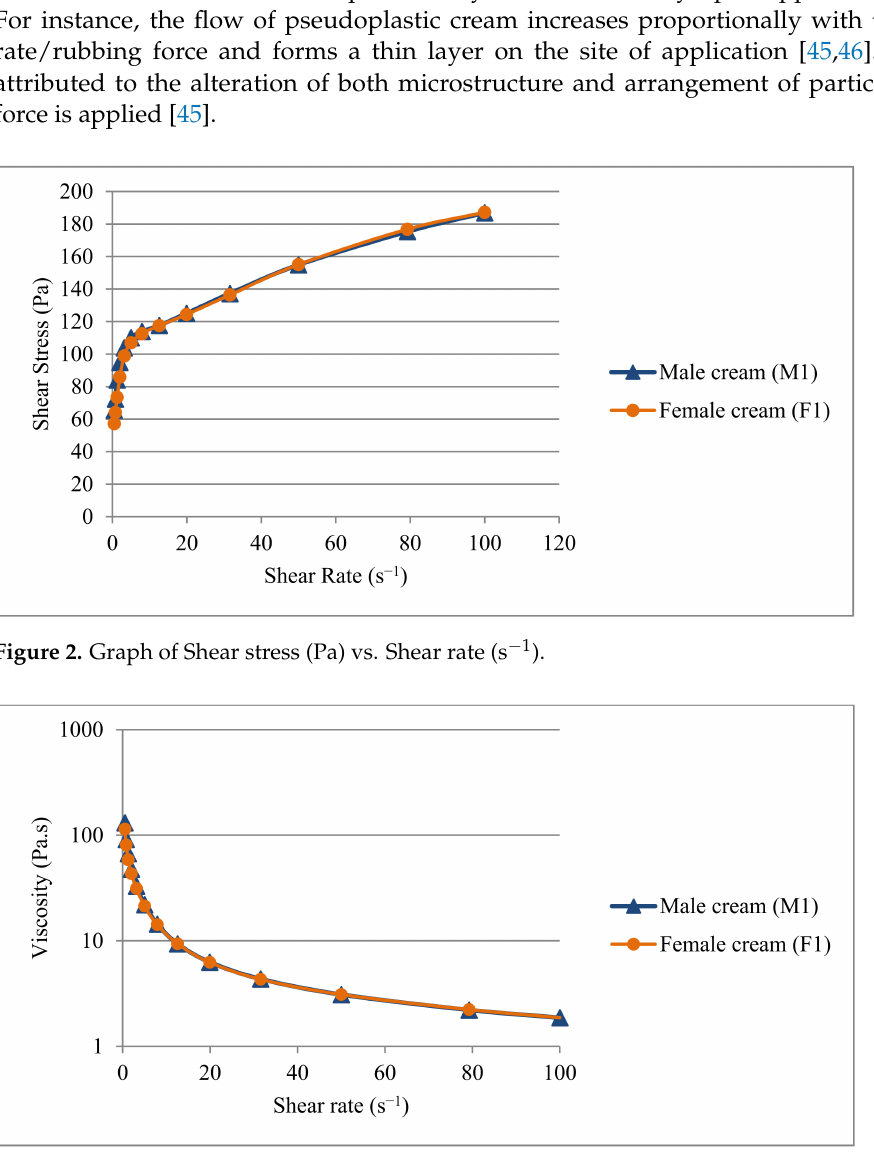
Figure 3. Graph of Viscosity (Pa.s) vs. Shear rate (s − 1